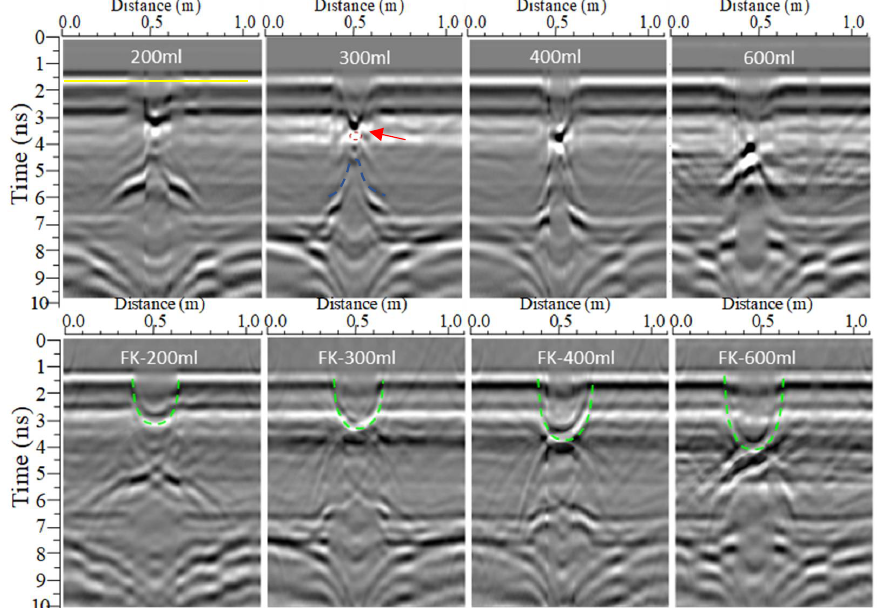
Figure 12. Radargrams of a drip irrigation SWB. The first line is the raw GPR radargram of the SWB with different irrigation volumes, named the irrigation volume. The second line is the FK radargram of the SWB, with a rough outline of said SWB (green dotted line), named “FK-irrigation volume”.